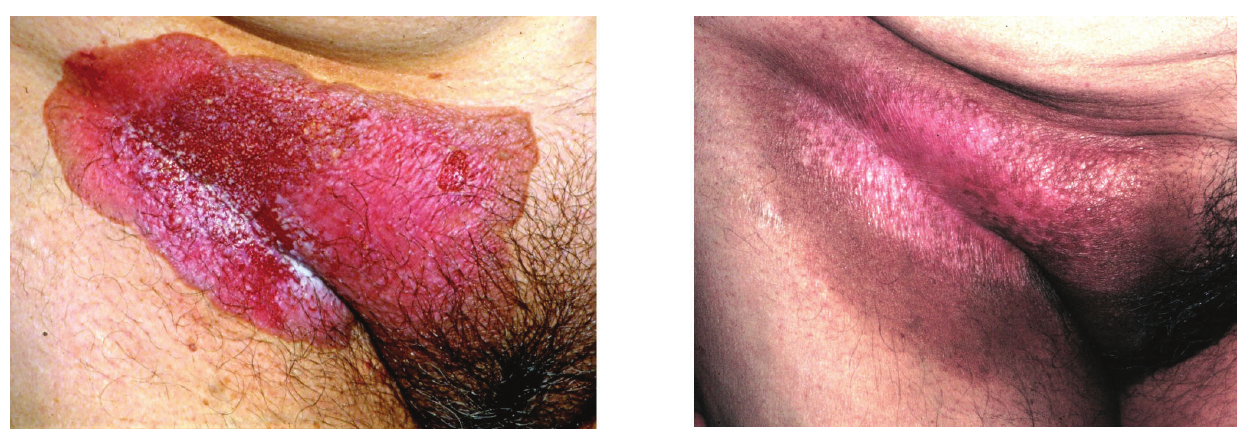
Figure 2 - Before and after